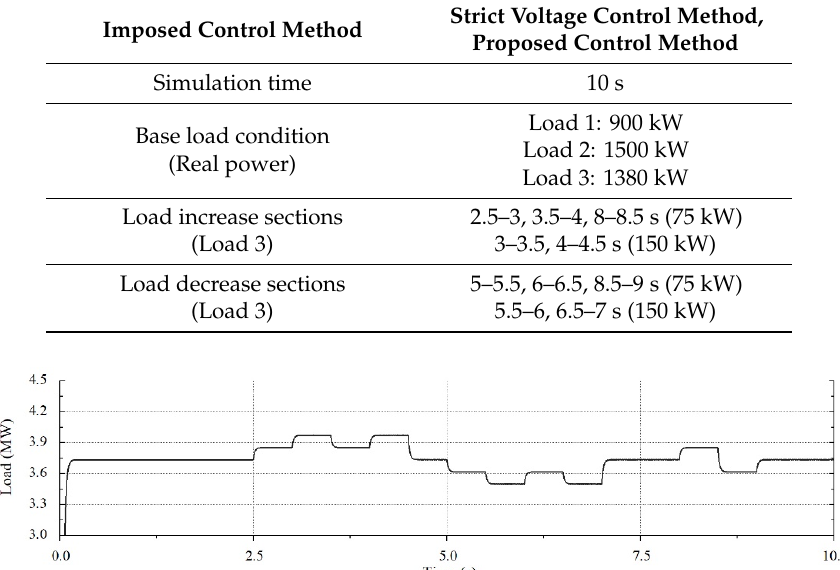
Figure 8. Simulated load variation in case study.